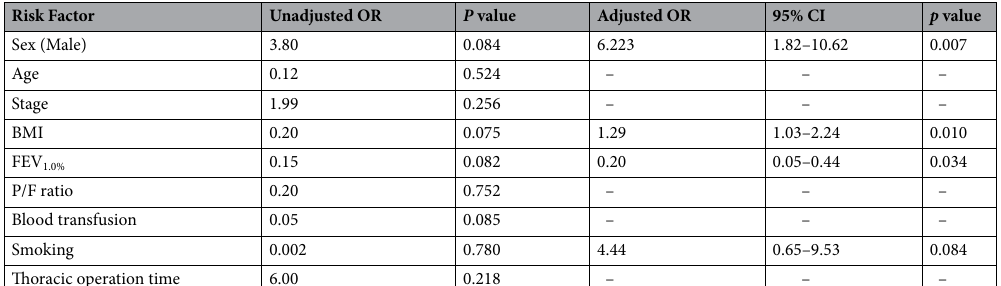
Table 4. Univariable and multivariate logistic regression analysis of the risk factors for Cdyn changes. P/F ratio, oxygen in arterial blood/fraction of inspired oxygen in the preoperative outpatient clinic; BMI, body mass index; FEV, forced expiratory volume; OR, odds ratio; CI, confidence interval; Cdyn: change in dynamic lung